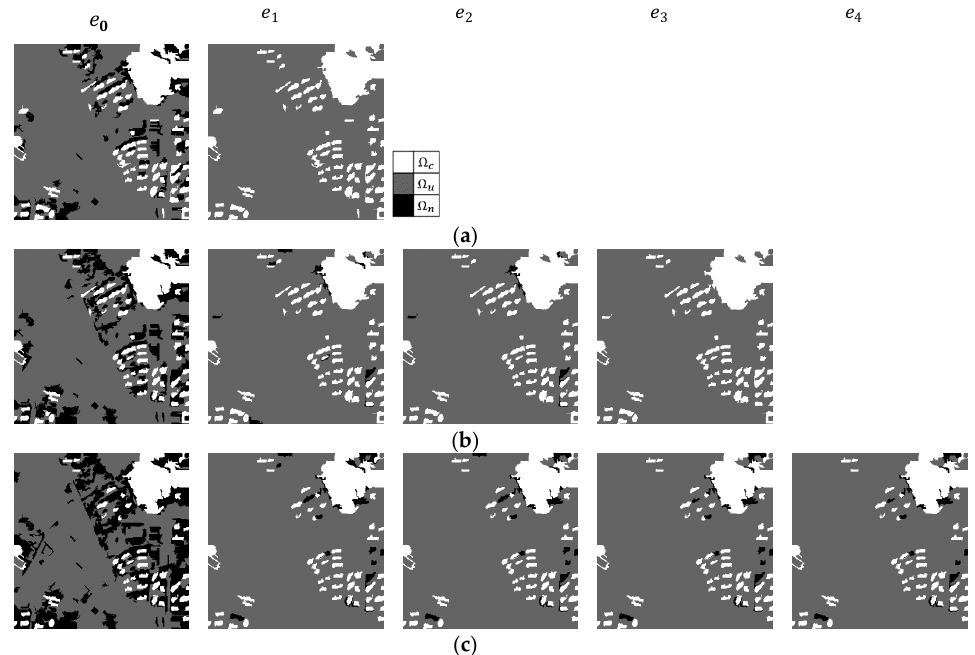
Figure 12. The CD results of the proposed methods for each epoch with different uncertainties (the uncertainty level maintains one value in the training phase) at Site 2: ( a ) Level 3; ( b ) Level 2; and ( c ) Level 1. Grey ( Ω c ) , white ( Ω u ) , and black ( Ω n ) colors represent the change, no-change, and no-value classes, respectively.